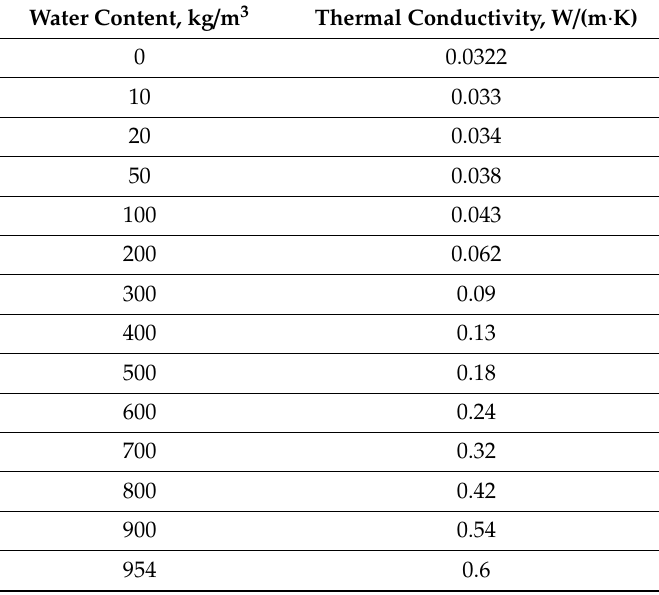
Table A10. MW thermal conductivity adjustment with water content.